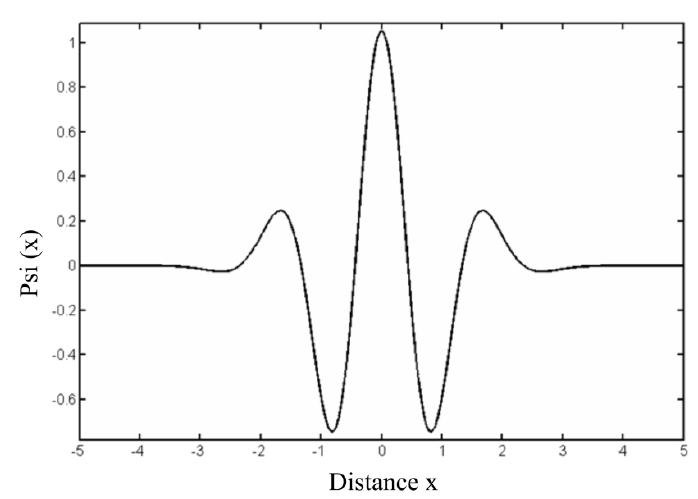
Figure 14. Gaussian order 6